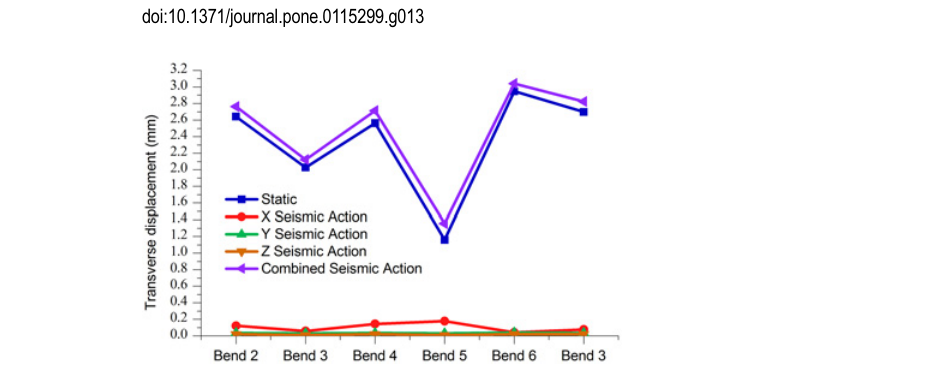
Fig 13. Longitudinal displacement of each bend under different working conditions.